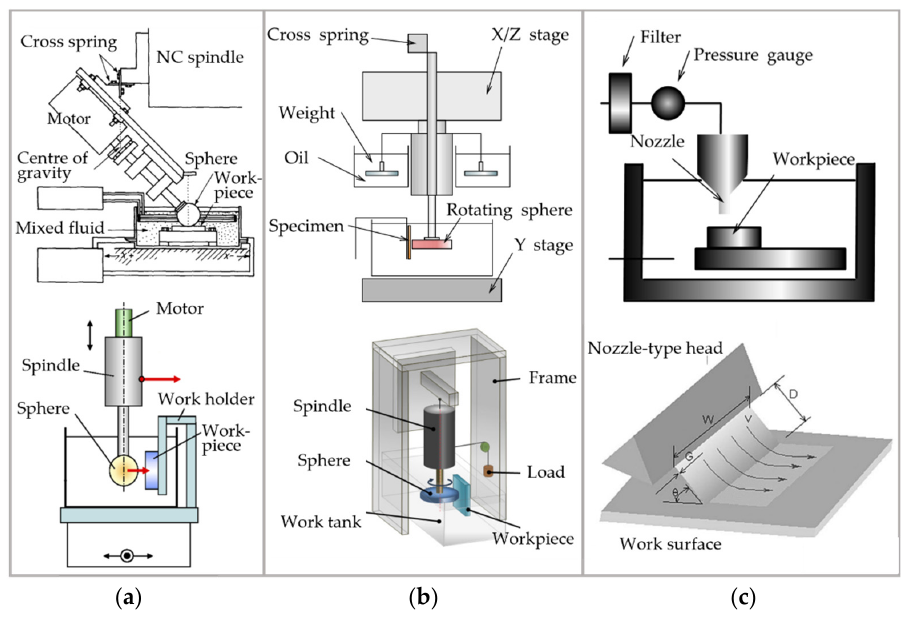
Figure 23. The schematic diagrams of elastic emission machining equipment: ( a ) Sphere type. Re- produced with permission from [30,162]; ( b ) Wheel type. Reproduced with permission from